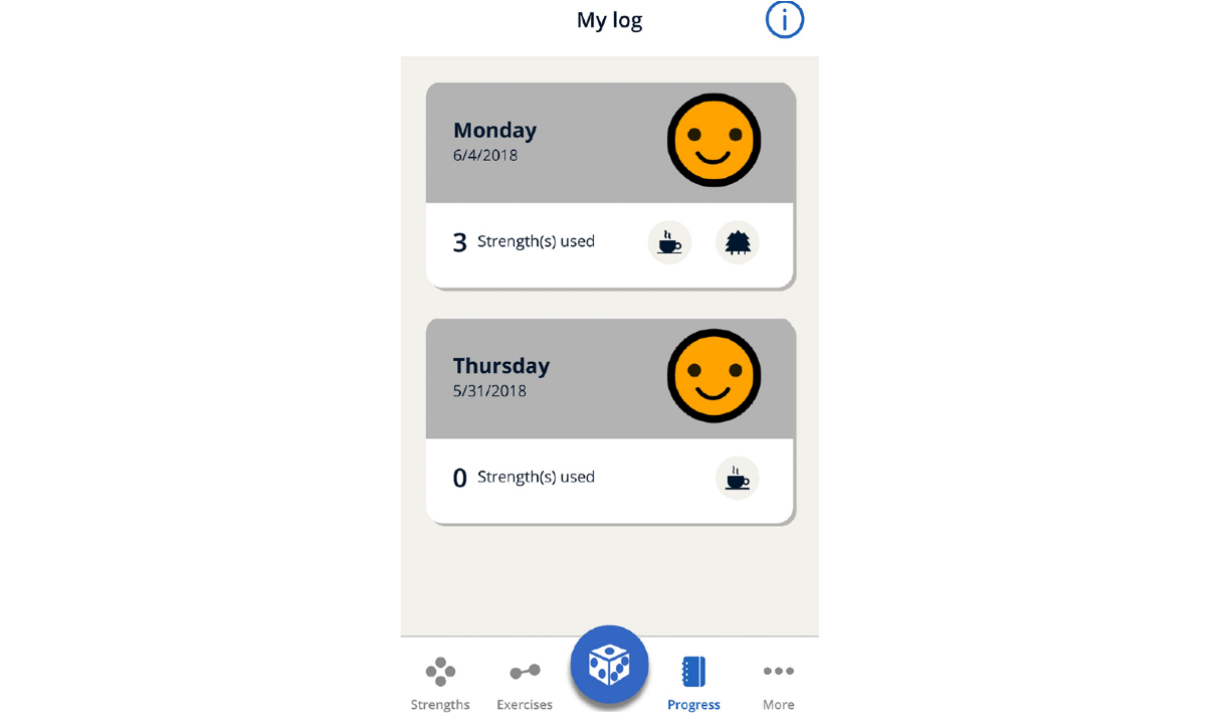
Figure 9. Daily log screenshot.